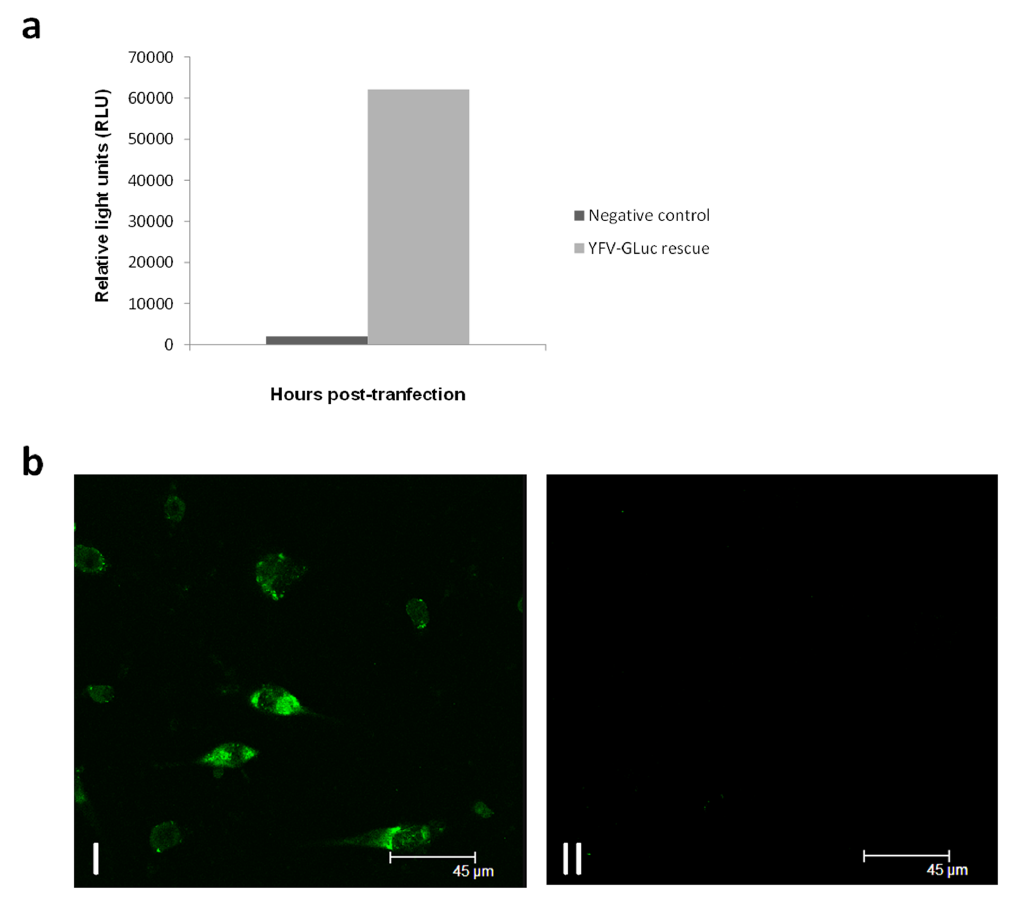
Figure 2 - a ) Gaussia luciferase activity on the supernatant of BHK-21 cells 120 hours post-transfection with YFV-GLuc RNA. GLuc activity is expressed as relative light units (RLU). Negative control: supernatant of electroporated cells without YFV-GLuc RNA. b ) IFA (63x magnification) performed with polyclonal hyperimmune mouse ascitic fluid raised against group B flaviviruses (primary antibody) and FITC-conjugated goat anti-mouse IgG antibody (secondary antibody). I) BHK-21 cells transfected with YFV-GLuc RNA at 120 h post-transfection; II) Negative control, mock-electroporated cells at 120 hours